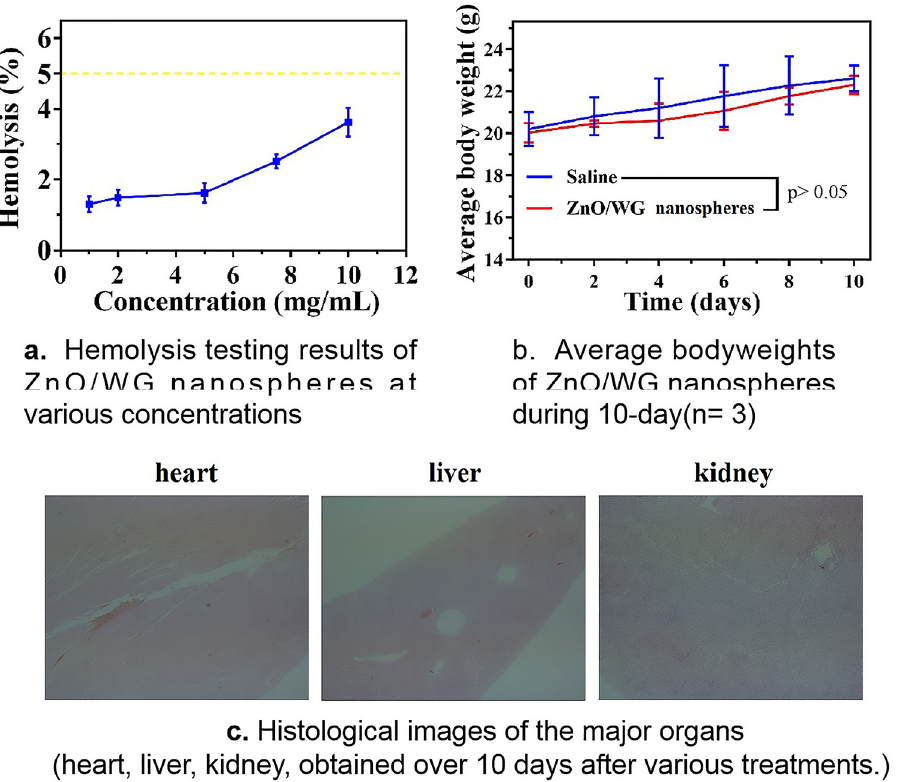
Figure 8. Safety